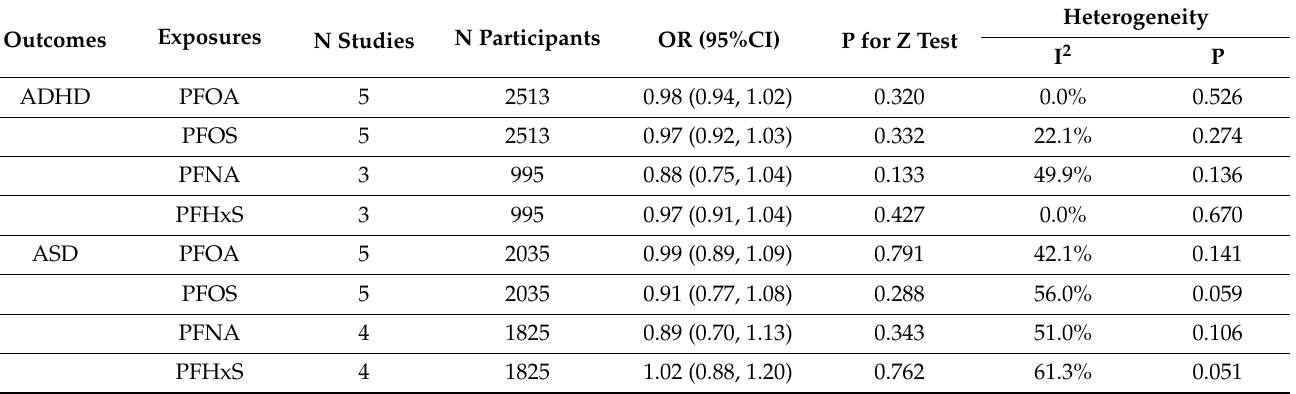
Table 2. Summarized odds ratios for ADHD and ASD associated with polyfluoroalkyl substances concentrations in the total concentration group.